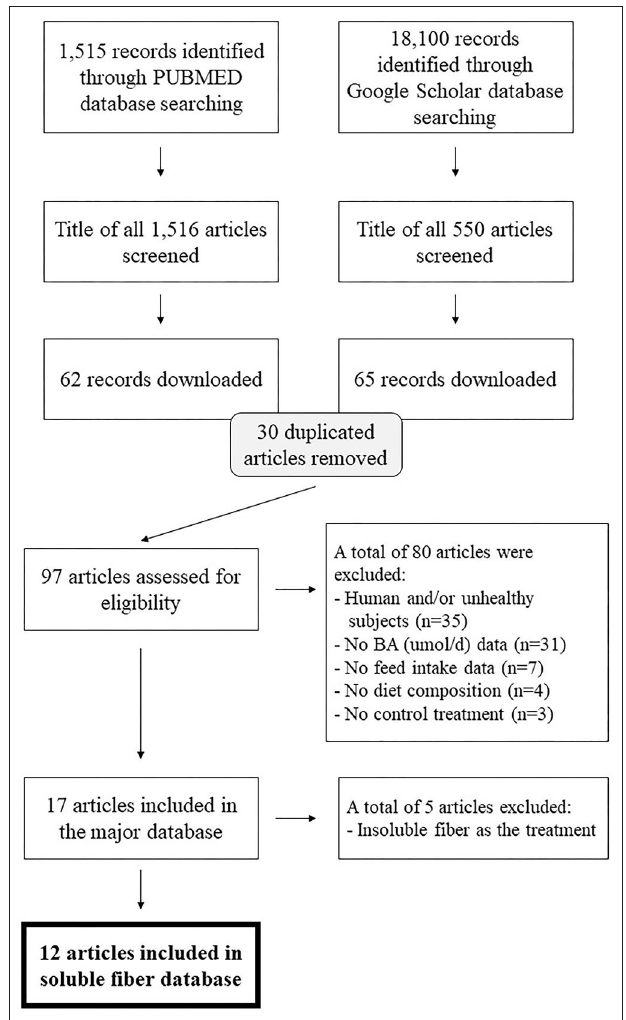
FIGURE 1 | Literature